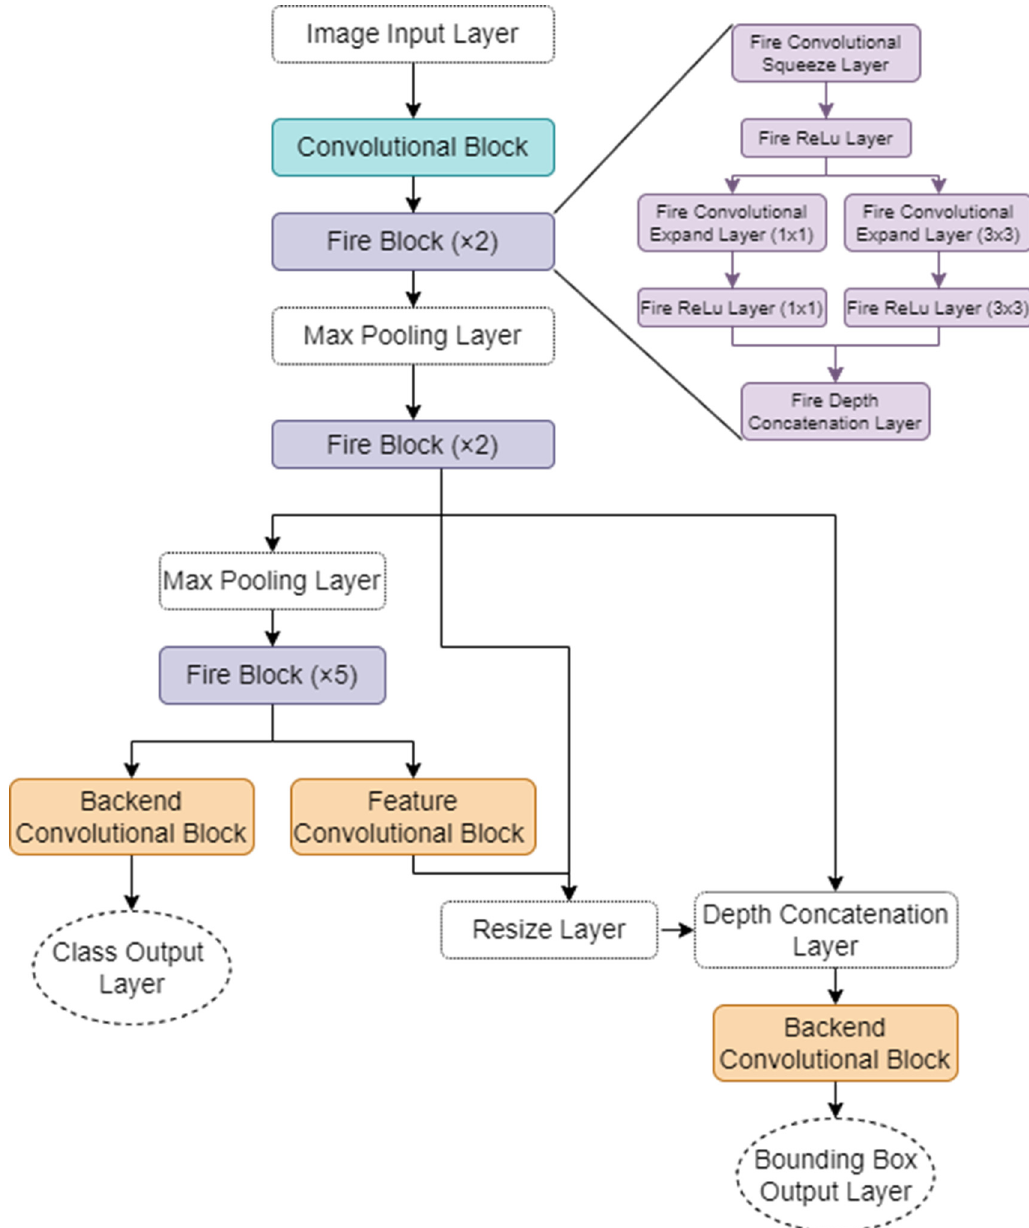
Figure 1. Basic overview of ShrapOD model network architecture. Diagram for the object detection algorithm using SqueezeNet [20] as the classification backbone, with added YOLOv3 outputs [16] to generate bounding boxes and class predictions is shown. In the diagram, individual layers are shown as well as “blocks” that consist of multiple layers. The convolutional block (teal) has a convolution layer, ReLU activation layer, and a max pooling layer. The Fire blocks (purple—that repeat two or five times as indicated) begin with a convolution layer with ReLU activation and then split into parallel chains with varying convolution filter sizes (1 × 1 and 3 × 3) with ReLU activation. As depicted in the first occurrence, then the parallel chains come back together using a depth concatenation layer. The feature convolutional block and both backend convolutional blocks are identical in layer content, beginning with a convolutional layer, followed by a batch normalization and ending with a ReLU activator. Both output layers, for class and bounding box are also convolutional layers. An additional output layer was used for bounding box predictions in which the net- work was fused after the Fire block 9 concatenation step with Fire block 8 with an